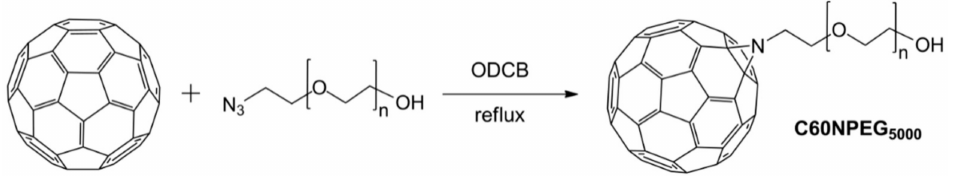
Figure 1. The scheme presenting synthesis of C60NPEG 5000 fullerene